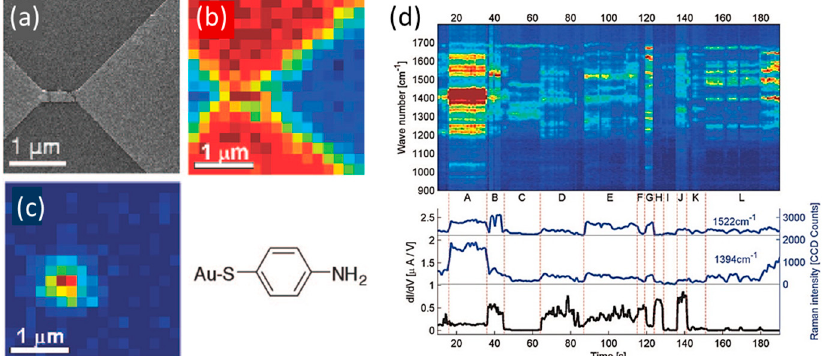
Figure 3. ( a ) Scanning electron microscope (SEM) image of the sample; ( b ) Map of the substrate Si 520 cm − 1 peak; ( c ) Map of the p-mercaptoaniline (pMA) SERS signal of 1590 cm − 1 (a 1 symmetry mode); ( d ) Waterfall plot of SERS and conductance for a pMA molecular junction ( λ ex : 785 nm, laser intensity: 0.5 mW) [34].